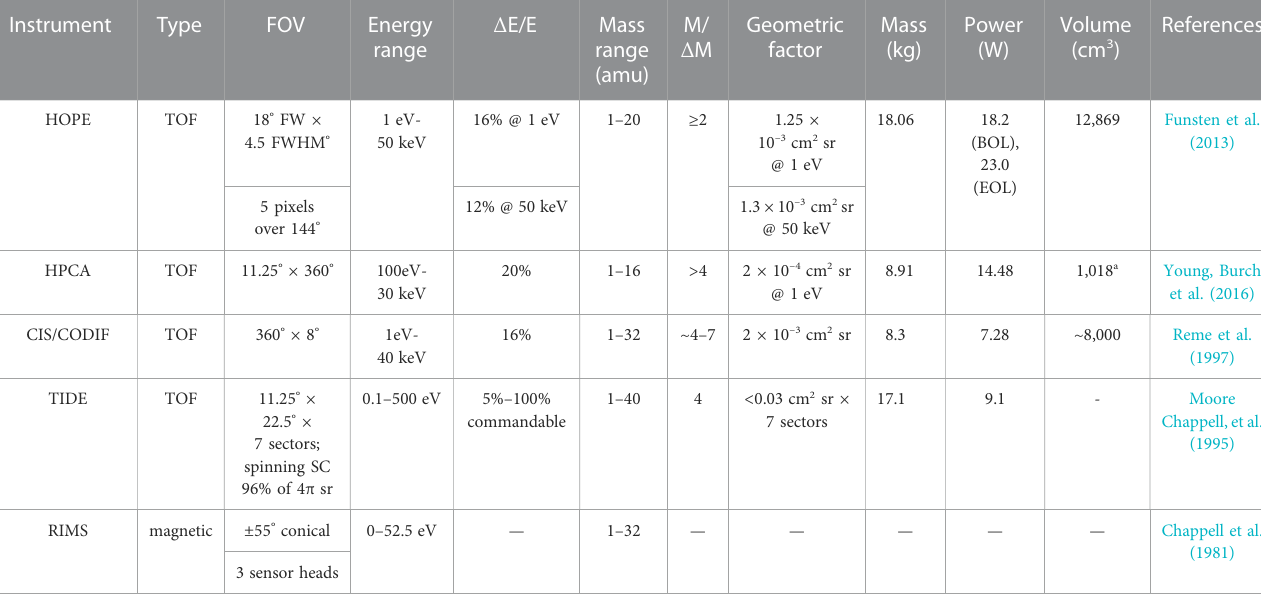
TABLE 1 Performance speci fi cations for representative state-of-the-art mass spectrometers.